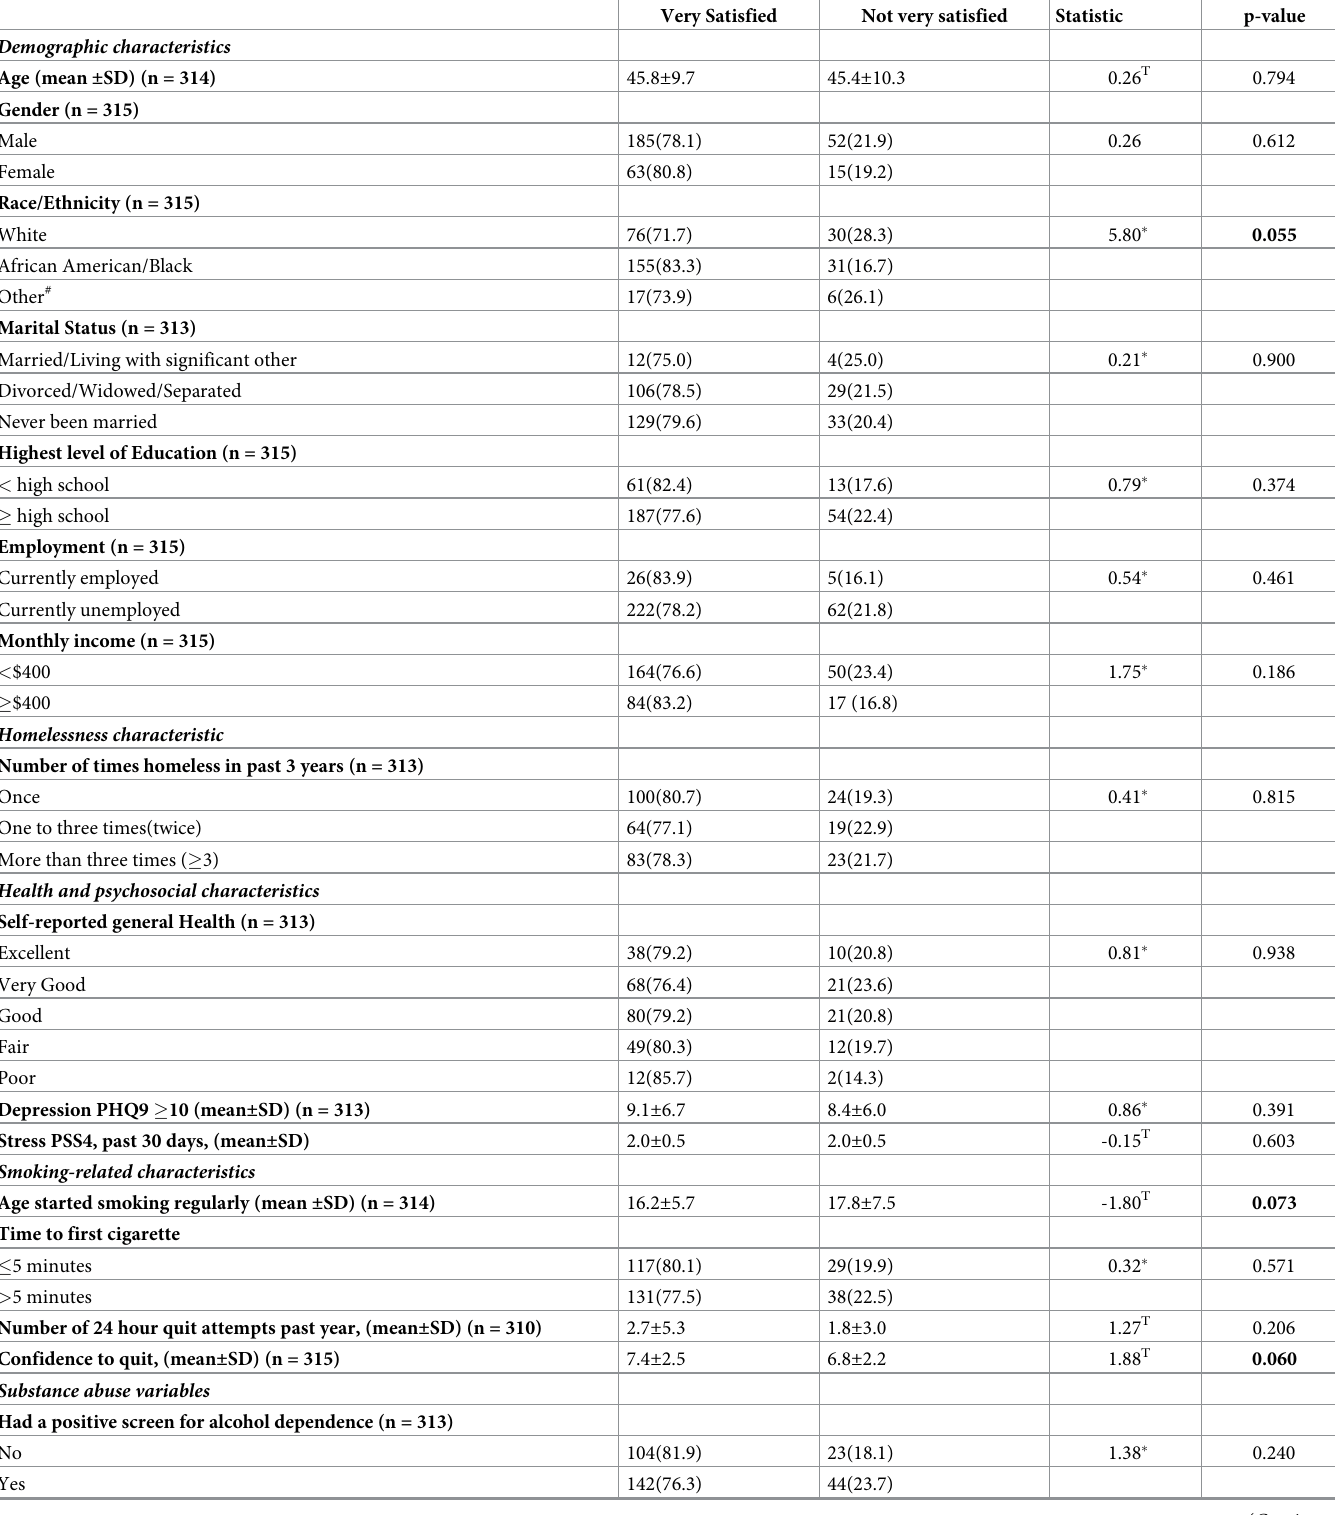
Table 4. The relationships between program satisfaction and other variables.